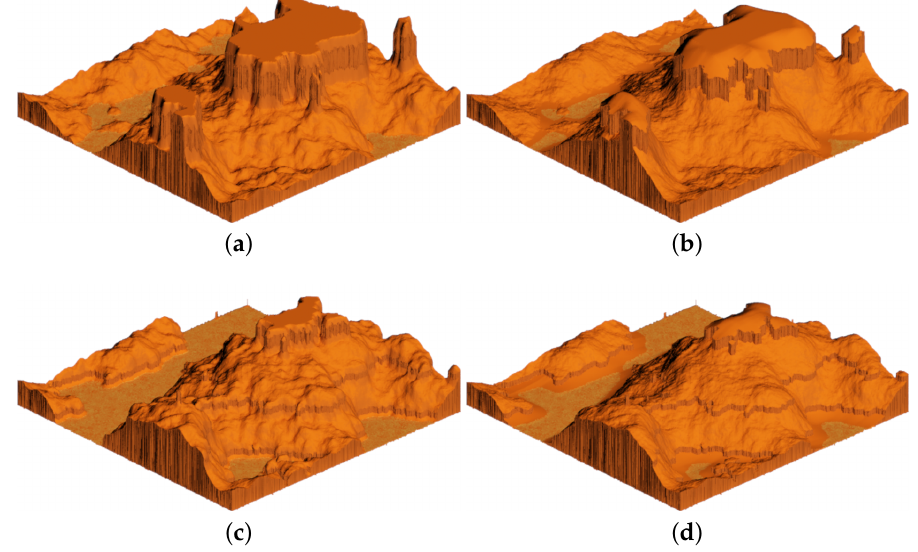
Figure 13. Comparison of the levelling impact on the sample mesa model shown in Figure 12. Erosive model was obtained for E = 0.5 with caprock. ( a ) ρ = 10, mat = 3. ( b ) ρ = 50, mat = 3. ( c ) ρ = 10, mat = 5. ( d ) ρ = 50, mat =